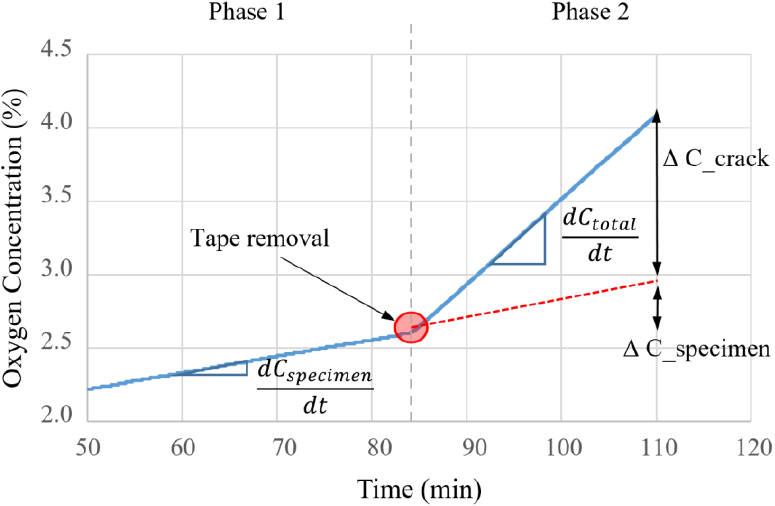
Figure 7. Schematic of variations in oxygen concentration before and after the start of diffusion through the crack.